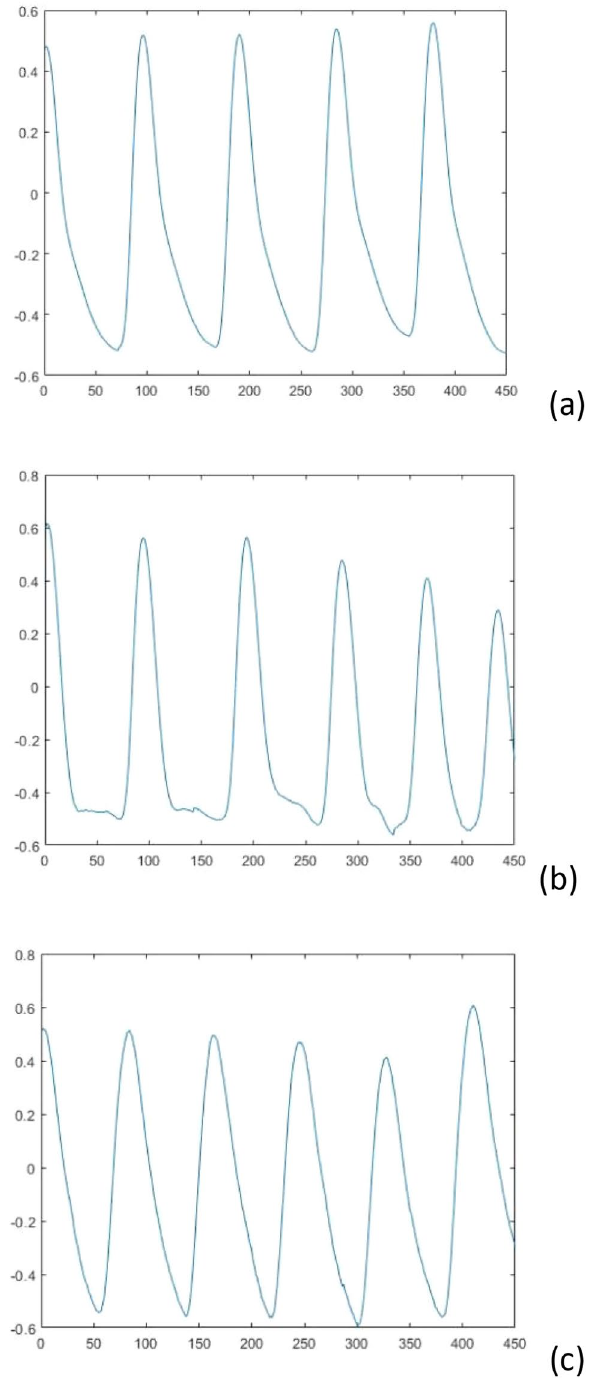
Figure 3. ( a ) CHFpulmonary edema; ( b ) Respiratory failure; ( c ) MIcardiogenic